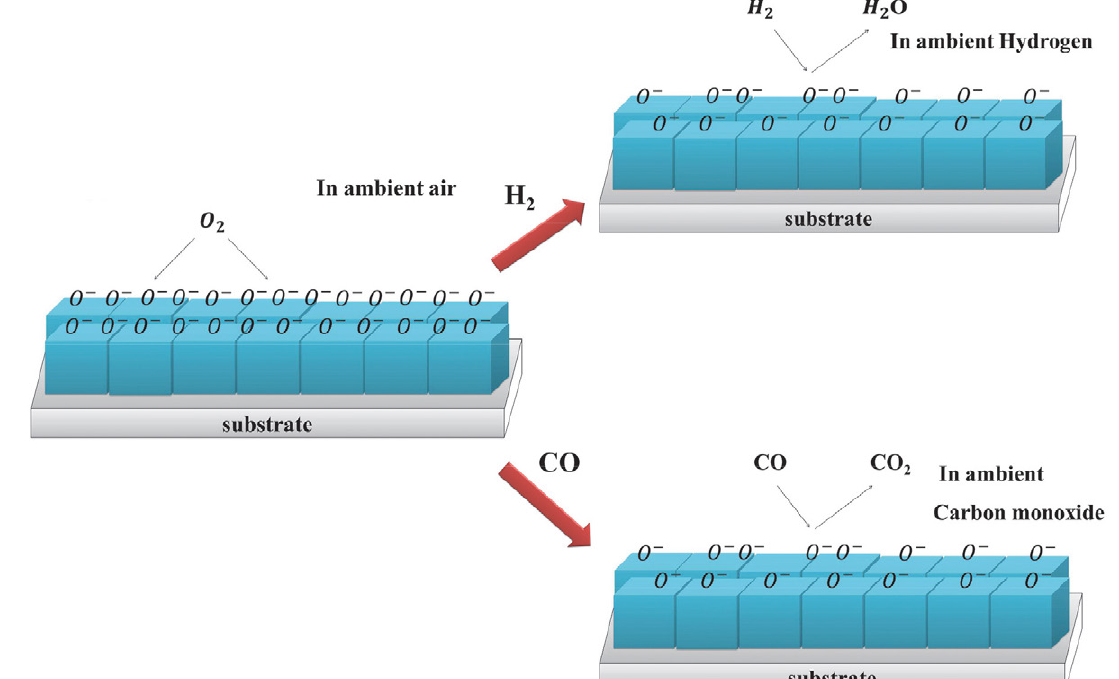
Figure 1 . The H 2 and CO sensing mechanism of resistance based MOS